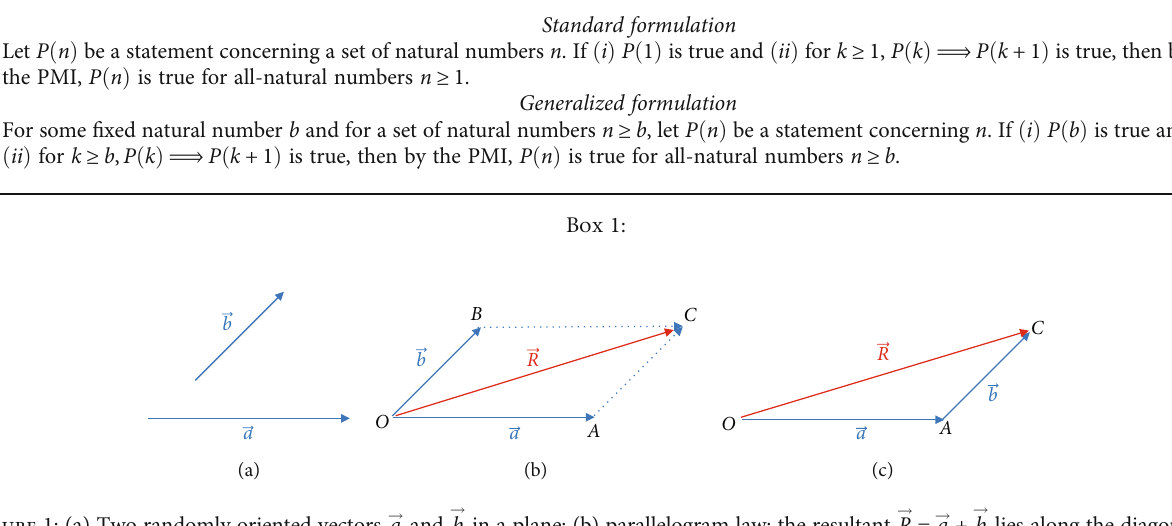
! ! = a ! + b ! ; (c) triangle law: the resultant R lies along the third side ! .